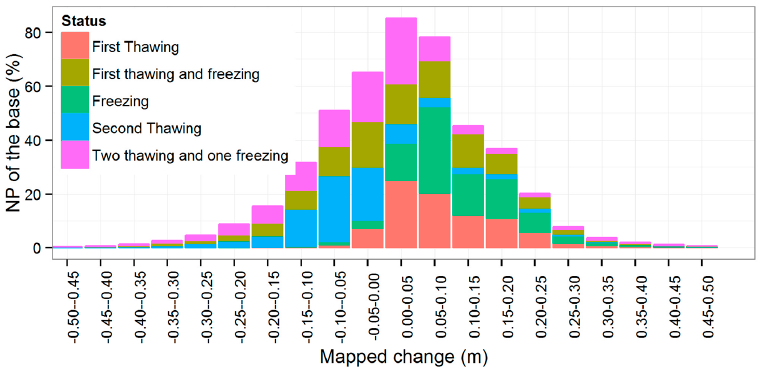
Figure 10. Normalized breakdown of the changes in the base of the slope mapped during the freeze– thaw cycles. NP denotes the normalized percentage.